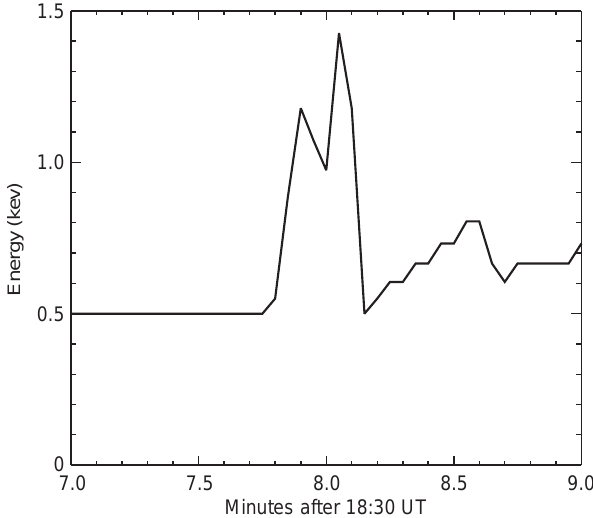
Fig. 7. Fitted Maxwellian peak energy of precipitating electrons for the time-period of arc passage through the EISCAT